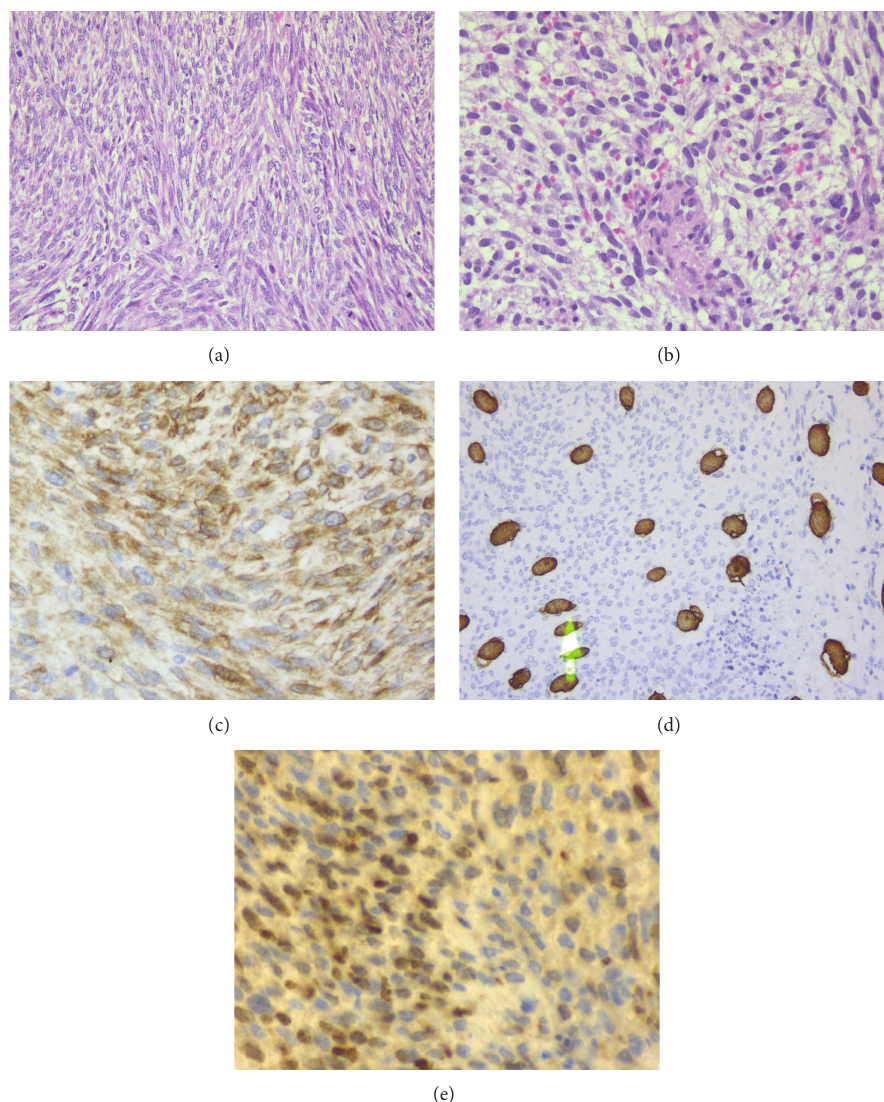
Figure 5: (a) Malignant triton tumor (MTT) cells. Spindle, fasciculated, and pleomorphic malignant schwannoma cells are appreciable with numerous mitotic figures in the field. (b) Eosinophilic rhabdomyoblasts within malignant schwannoma cells. (c) Positive immunohistochem- ical stain with NF-200 highlighting neurofilamentous component of tumor. (d) Positive immunohistochemical stain with desmin. (e) Positive immunohistochemical stain with MyoD transcription factor demonstrating myogenic component of